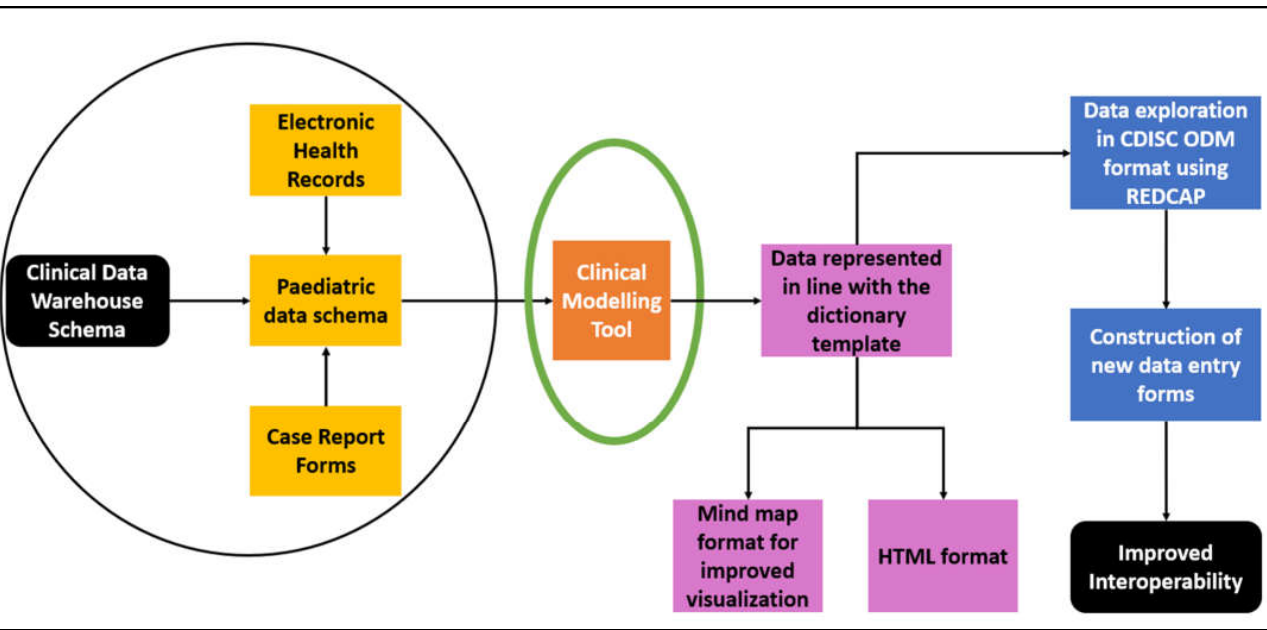
Figure 9. Schematic diagram of the role of a modelling tool in a clinical trial environment.